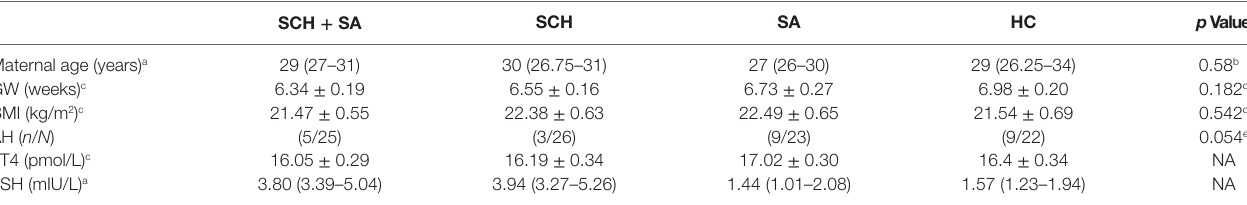
TaBle 2 | Characteristics of patients. sch + sa sch